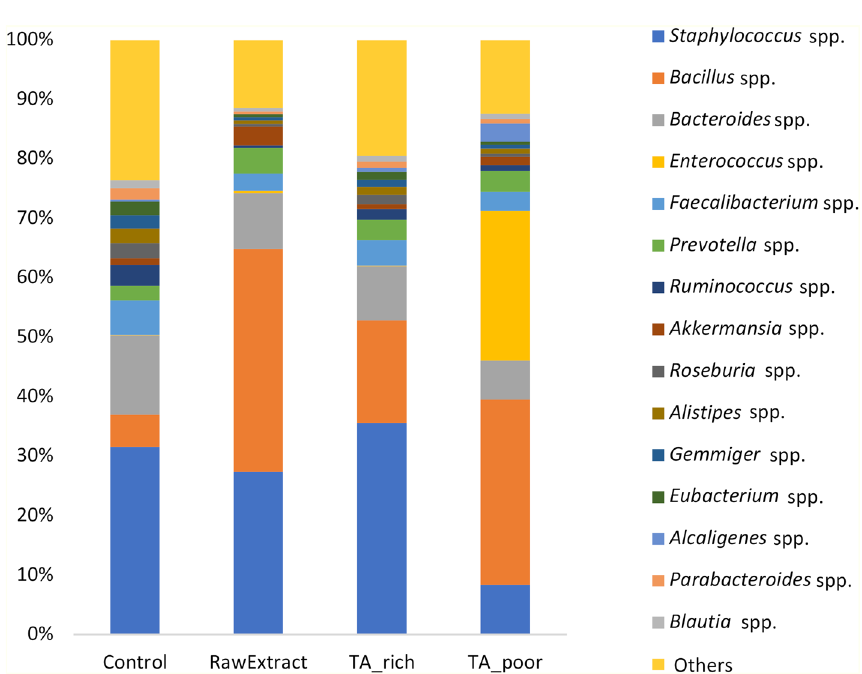
Figure 3. Relative abundances of the fifteen most prevalent genera in all feeding